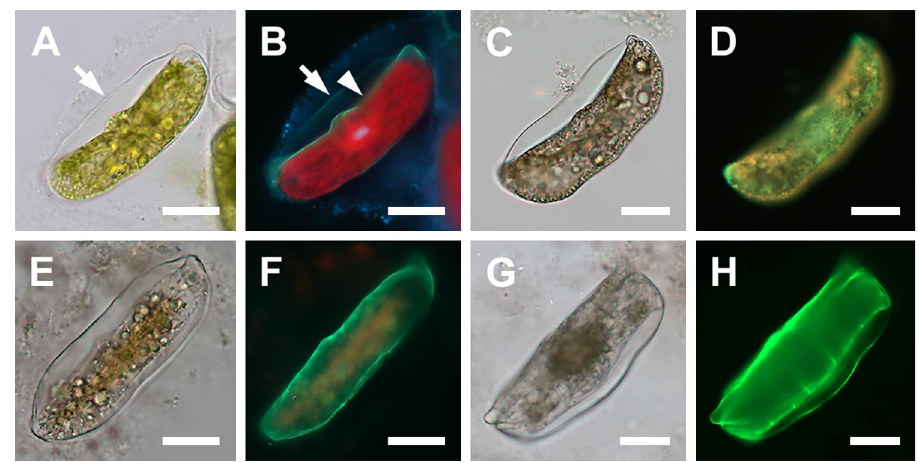
Fig 5. Mature auxospores and deposition of initial valves (brightfield and DAPI/PDMPO epifluorescence light microscopy). (A, B) Mature auxospore in girdle view showing deposition of initial epivalve (arrowhead in B) underneath siliceous wall elements deposited earlier (arrow). (C, D) Mature auxospore in girdle view with more developed initial epivalve, PDMPO-labeled green in (D). Note the absence of internal costae. (E, F) Valve face view of auxospore with initial cell protoplast retracted along both sides of auxospore. (G, H) Mature auxospore with initial frustule in girdle view with the remnants of auxospore wall over the initial hypotheca with internal costae. All scale bars: 50 μ